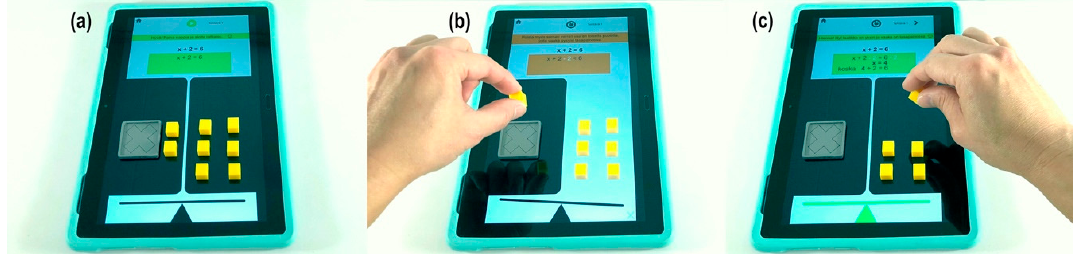
Solving the equation by doing the same operation on both sides of the scale; ( c ) The solved equation